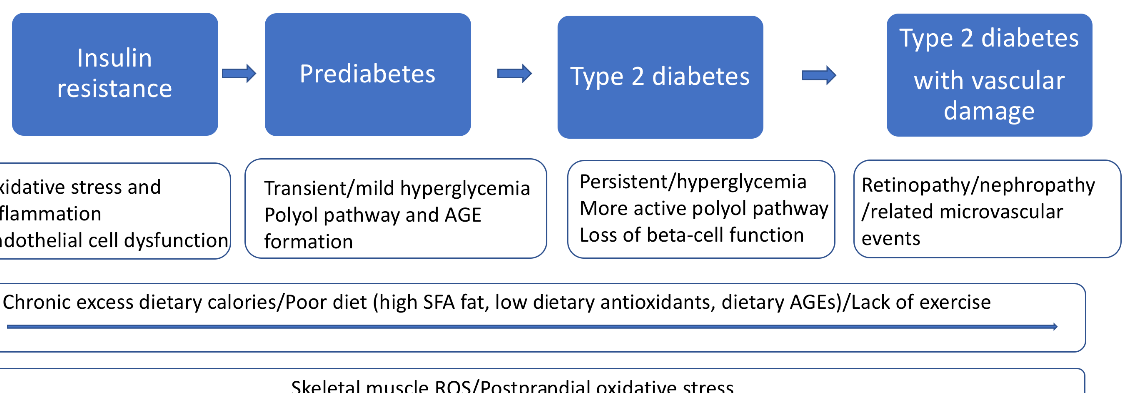
Figure 1. The stages of Type 2 Diabetes (T2D). Chronic excess calories produce skeletal muscle mitochondria reactive oxygen species (ROS) emission, which, along with dietary AGEs, initiates insulin resistance and contributes to postprandial oxidative stress. Insulin resistance and the resulting hyperglycemia activate the polyol pathway with additional AGE-formation that amplifies oxidative stress/inflammation and contributes to beta-cell dysfunctions. Skeletal muscle ROS formation and postprandial oxidative stress will continue to act deleteriously throughout all four stages of T2D (long blue arrow) unless treated with lifestyle and medical interventions. High levels of dietary AGEs and low levels of dietary antioxidants will also contribute to postprandial oxidative stress and accelerate T2D progression.